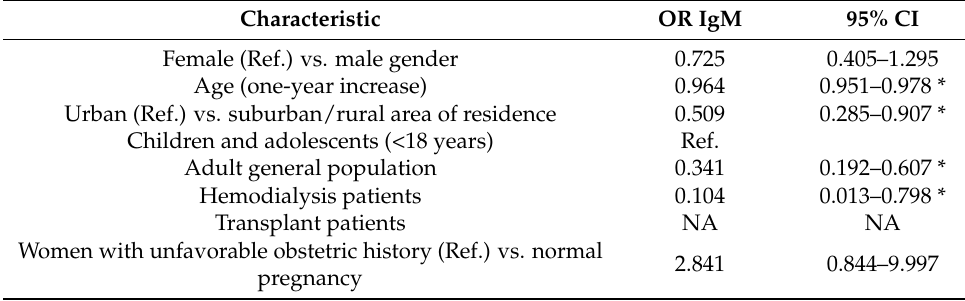
Table 4. Logistic regression risk analysis for the parvovirus B19 IgM seropositivity. Characteristic